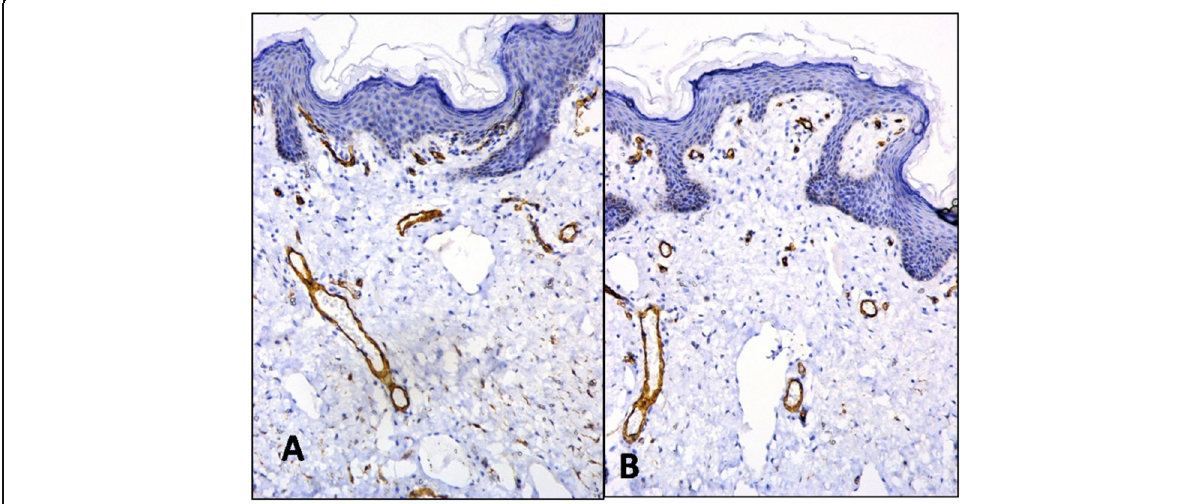
Fig. 6 Histo-patholological evaluation of genital skin biopsies: immune-staining for commercially available ready to use mouse monoclonal antibody against CD31 which is a vascular marker indicating neovascularization supposed to play a fundamental role in the healing process. There was an equal mild to moderate expression in both groups: ( a ) hormonally treated group; ( b ) the ‘ untreated ’ group (original magnification ×